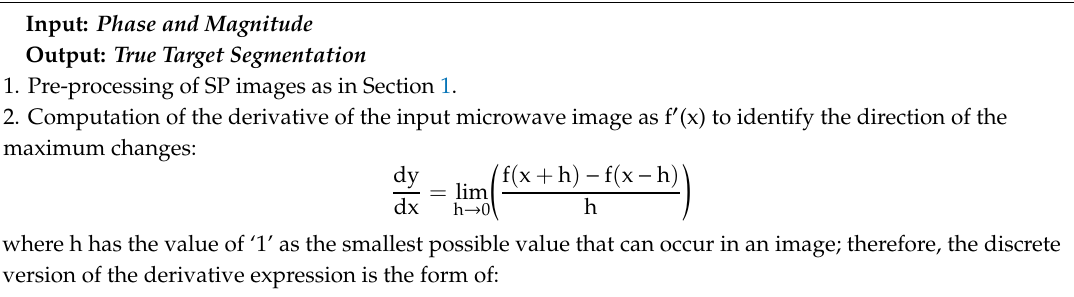
Pseudocode 1. The proposed FT-based algorithms for defect segmentation in microwave